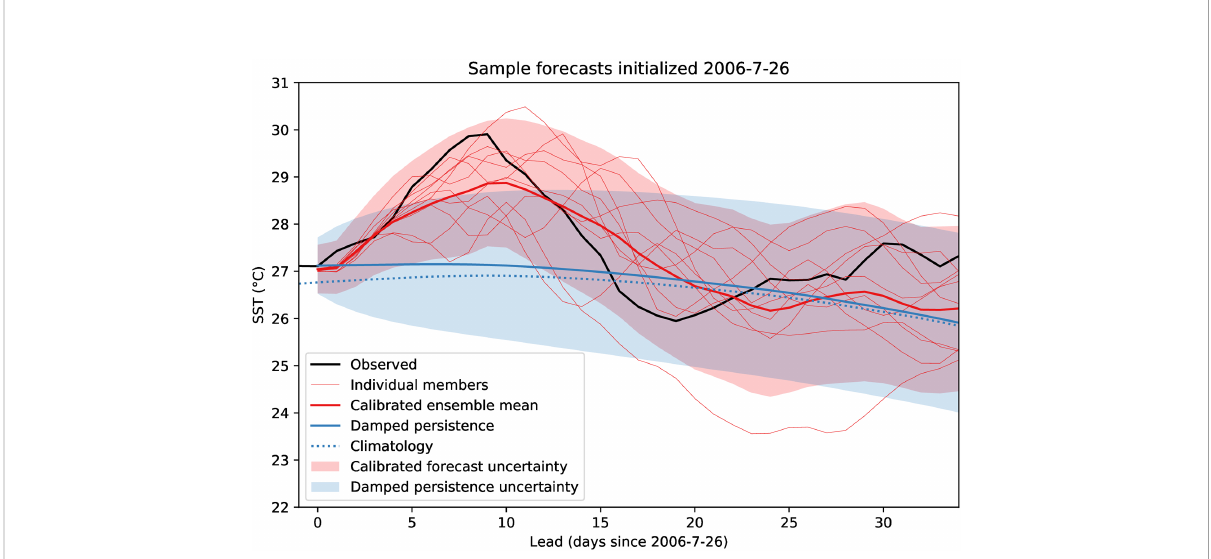
FIGURE 2 Demonstration of a set of model forecasts (red) and reference forecasts (blue) for SST at the Thomas Point station initialized on July 26, 2006, and the SST observed at the station (black). Shaded regions indicate 80% prediction